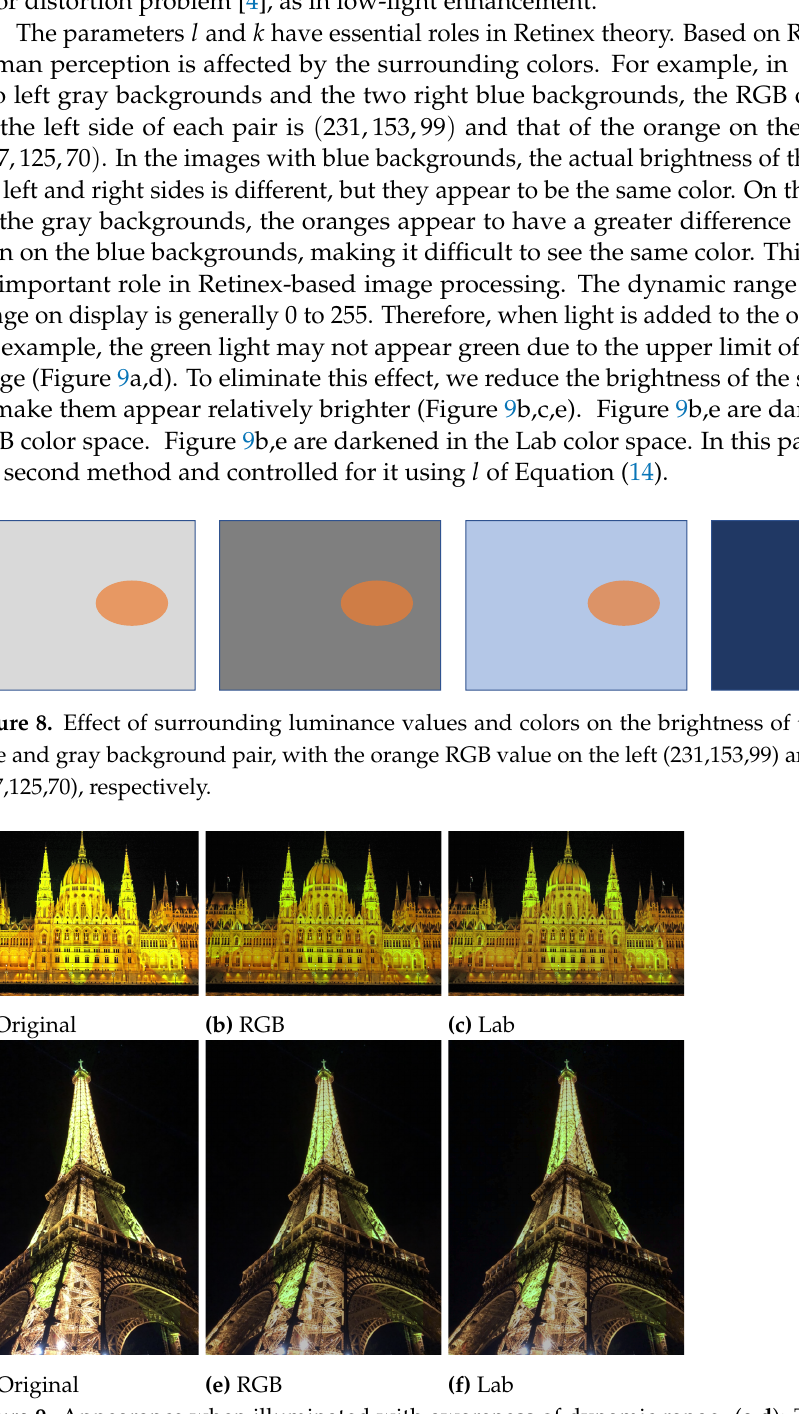
Figure 9. Appearance when illuminated with awareness of dynamic range. ( a , d ): The luminance value is added to the original image. ( b , e ): The luminance value is added after darkening the original image by reducing RGB values ( l = 0.75). ( c , f ): The luminance value is added to the RGB image that is converted to Lab color space ( l l = l a = l b =